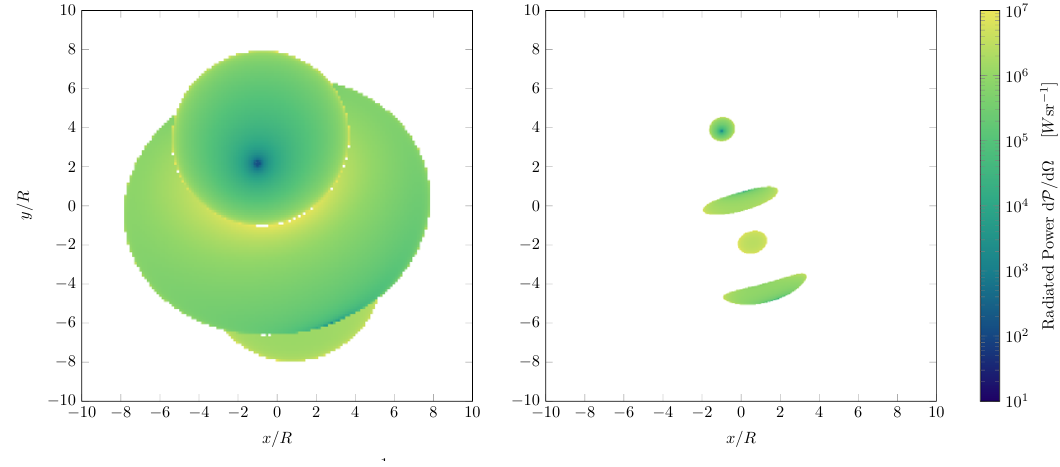
Figure 2 . Radiated power in image plane: vacuum vs. plasma. The view of radio photons at frequency ω ’ m a produced by axion dark matter conversion, as seen in the image plane perpen- dicular to an observing angle θ = 36 ◦ . We chose model parameters compatible with observations of NS J0806.4-4123, with B 0 = 2 . 5 × 10 13 G, period P = 11 . 37sec and magnetic misalignment angle α = 18 ◦ . The axion mass chosen was m a = 0 . 5 µ eV with a coupling g aγγ = 10 − 12 GeV − 1 . The left image results from straight-line rays propagating through vacuum, reproducing the results of [41]. The right panel shows the presence of novel plasma effects considered in this work, computed via eq. (3.4). The time evolution of the image in the plasma case can be viewed here and can be contrasted against the vacuum case derived in